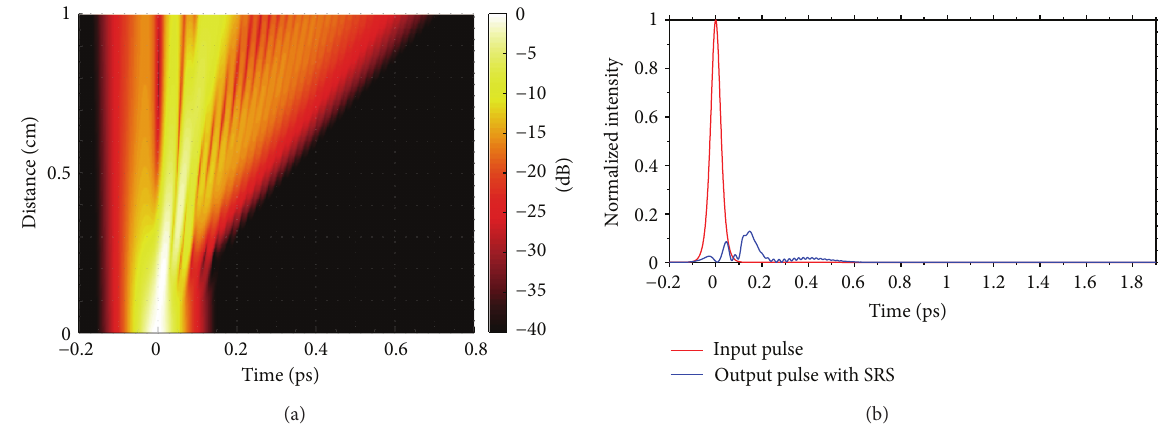
Figure 9: (a) Temporal evolution for the 1cm long silicon waveguide without considering the effect of stimulated Raman scattering. (b) ContrastoftheinputpulseandoutputpulsewithoutconsideringtheeffectofstimulatedRamanscattering.Theinputsolitonis50fs(FWHM), 25 W peak power hyperbolic secant soliton with order 𝑁 = 3